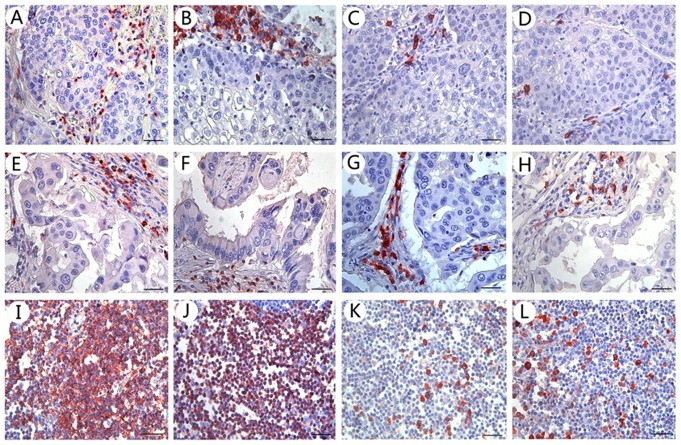
Receptors for Igγ were not expressed on the cellular membrane of lung cancer cells.CD16 (Fcγ receptor III) is shown in LSCC (A) and LAC (E) tissues. CD32 (Fcγ receptor II) is displayed in LSCC (B) and LAC (F) tissues. CD64 (Fcγ receptor I) is shown in LSCC (C) and LAC (G) tissues. FcRn (neonatal Fcγ receptor) is shown in LSCC (D) and LAC (H) tissues. In those sections, positive signals are only expressed in the cytoplasm and membrane of lymphocytes, while no positive signals are found in cancer cells. CD16 (I), CD32 (J), CD64 (K) and FcRn (L) are expressed in biopsied human tonsil tissues as positive controls. Bar: 20 µm.